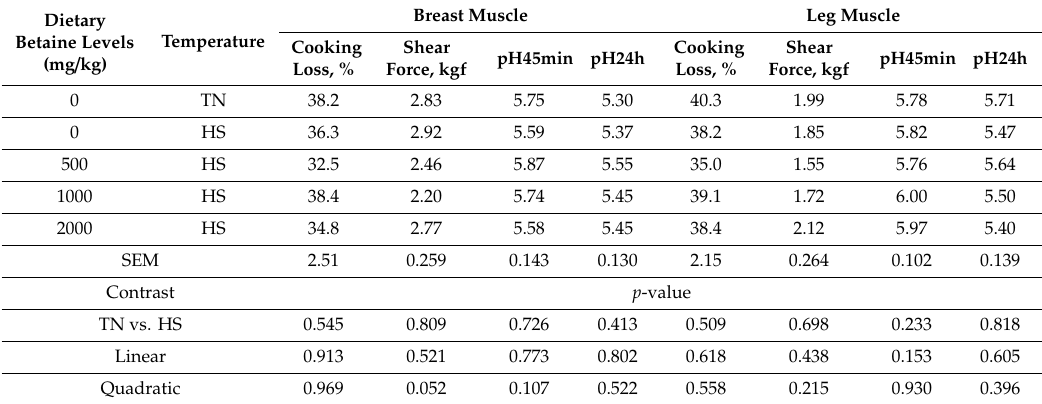
Table 7. E ff ects of heat stress and dietary betaine on meat quality of yellow-feathered broilers *. Dietary Betaine